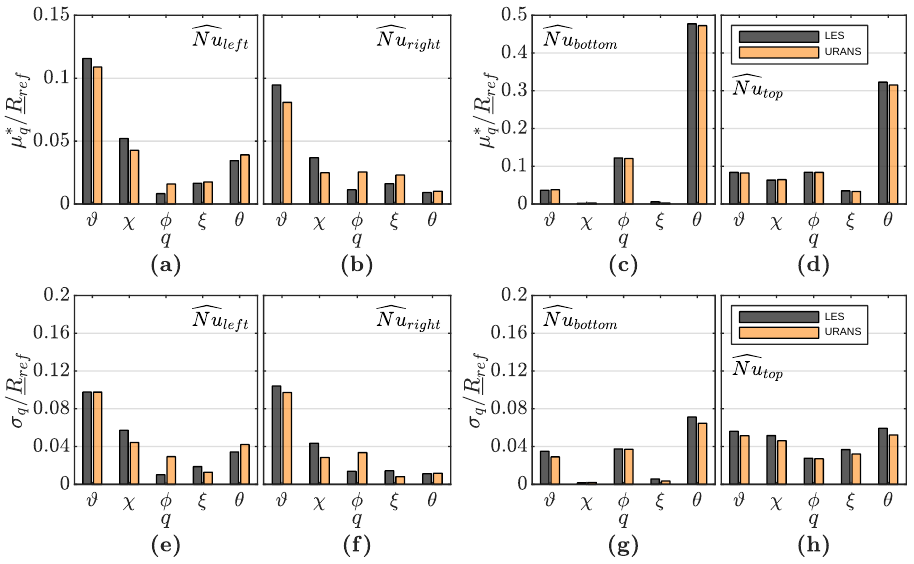
Figure 10. Normalized modified mean µ ∗ / R ref and standard deviation σ q / R ref of the mean absolute q deviation to the reference case of the Nusselt number: ( a , e ) on the left wall, (cid:99) Nu left ; ( b , f ) on the right wall, (cid:99) Nu right ; ( c , g ) on the bottom wall, (cid:99) Nu bottom ; and ( d , h ) on the top wall, (cid:99) Nu top .